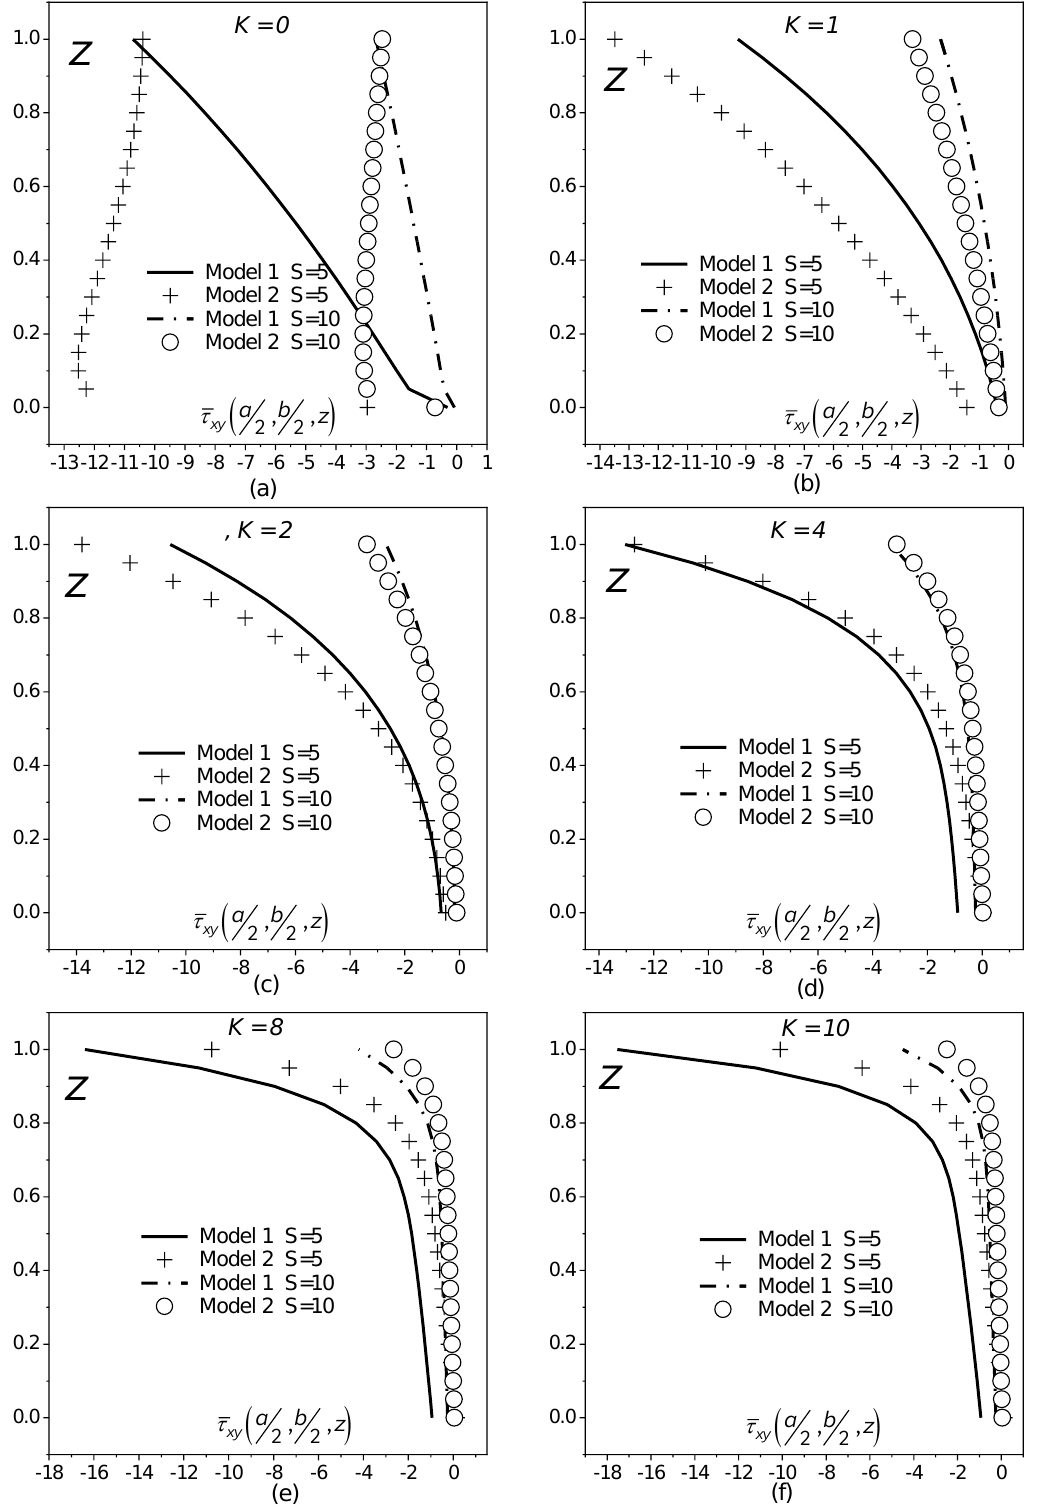
 ) for different material graded FG xy square laminate for material set